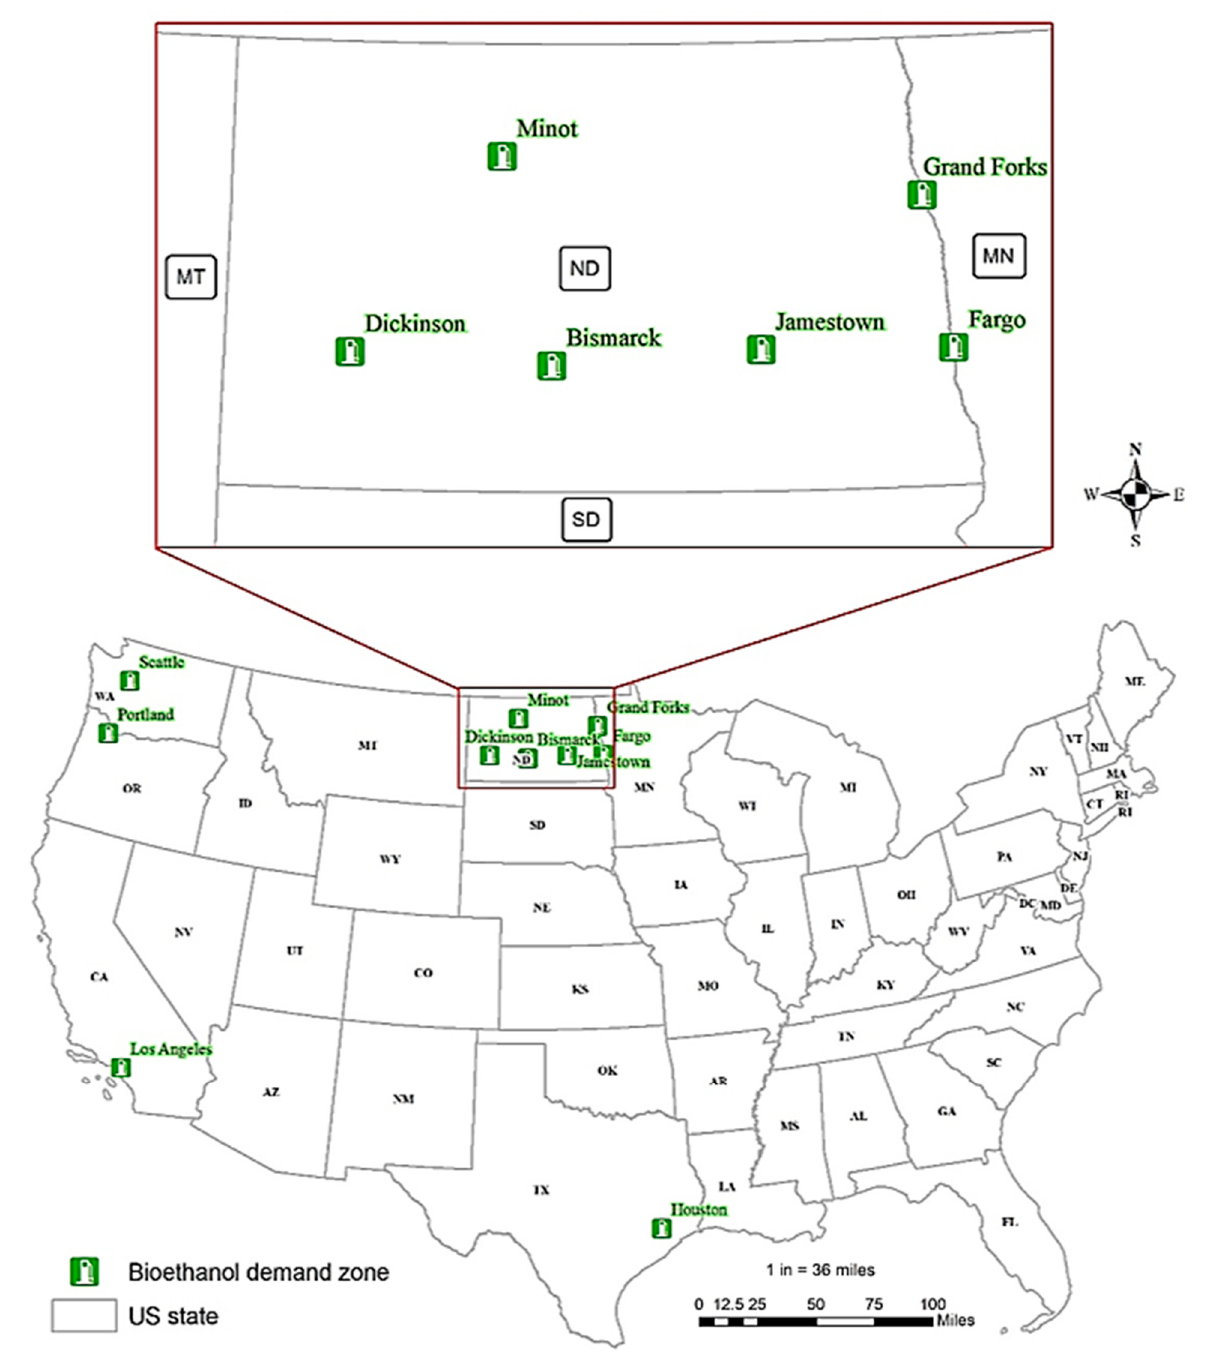
Figure 3. In ‐ state and out ‐ of ‐ state demand zones. Figure 3. In-state and out-of-state demand